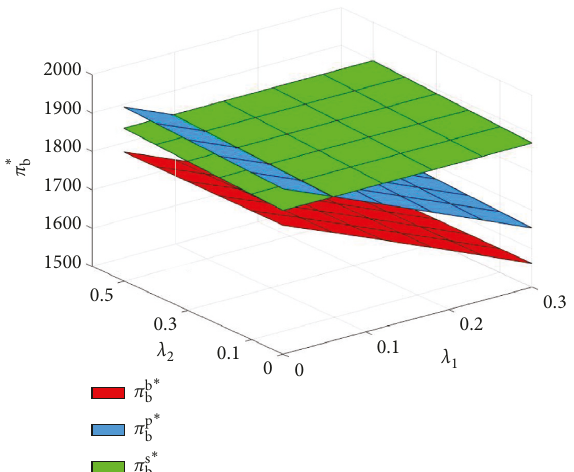
Figure 5: Impact of change in λ 1 and λ 2 on the catering business’s optimal profit.